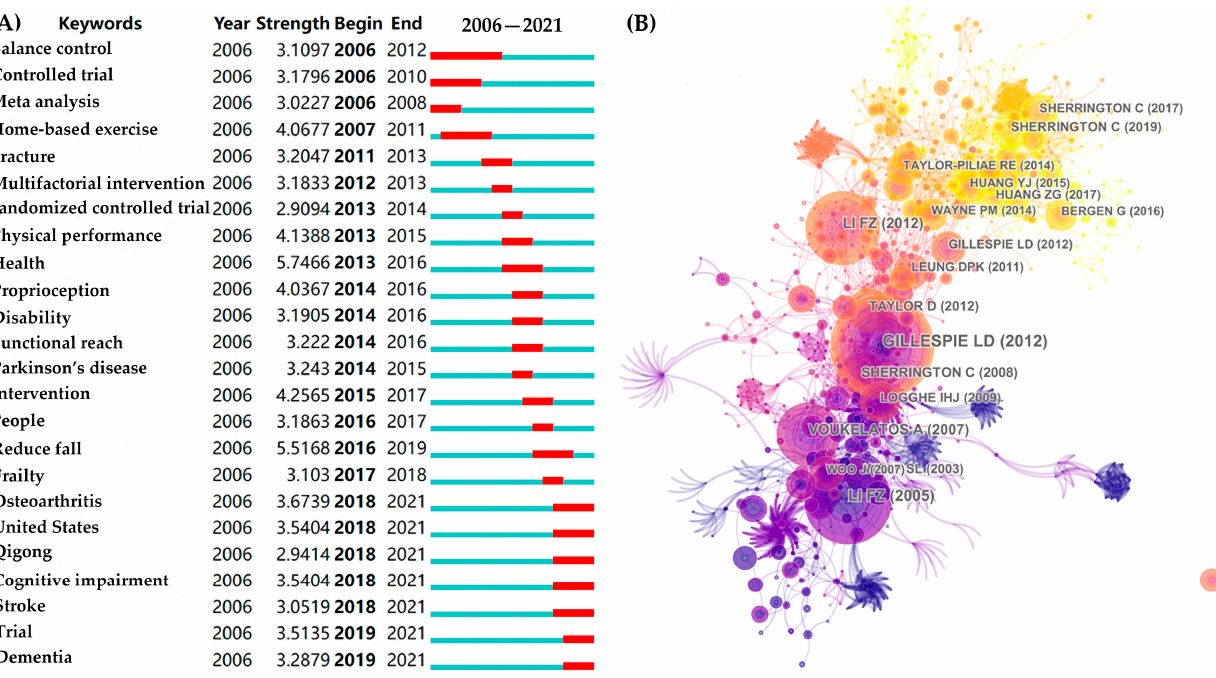
Figure 9. ( A ) Visualized map of burst keywords; ( B ) visualized map of co-cited reference. Table 2. Top six co-cited references with high centrality (centrality ≥